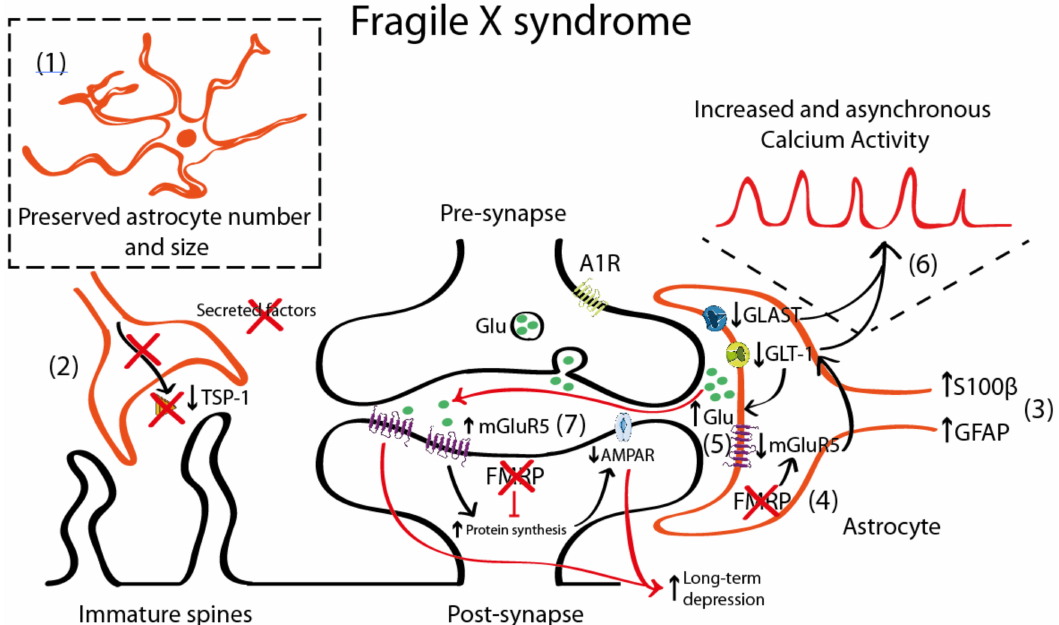
Figure 1. Schematic representation illustrating the astrocyte-synapse alterations in Fragile X syndrome (FXS). ( 1 ) Astrocyte number is preserved. ( 2 ) Reduced astrocyte secreted thrombospondin (TSP-1) prevents spine maturation resulting in more abundant filopodia (immature) spines. ( 3 ) Increased S100 calcium-binding protein β (S100 β ) and GFAP expression has been described in astrocytes. However, this altered expression has not been directly linked with their activity or function. ( 4 ) Fragile X Mental Retardation Protein (FMRP) absence in FXS astrocytes leads to metabotropic glutamate receptor 5 (mGluR5) downregulation in astrocytes (yet not in neurons) that negatively regulates glutamate transporter 1 (GLT-1) expression. Impaired glutamate transport due to decreased astrocyte glutamate-aspartate transporter 1 (GLAST-1) and GLT-1 expression increases extracellular glutamate levels ( 5 ) and astroglial calcium oscillations ( 6 ). This excess of glutamate might activate the postsynaptic mGluR5, which is overexpressed in neurons. ( 7 ) mGluR5 and FMRP oppositely regulate mRNA translation at the synapse: mGluR5 promotes it and FMRP prevents it. Therefore, increased mGluR5 expression and lack of FMRP in FXS leads to a disbalance in protein expression levels that account for many of the syndromic features of FXS including an α -amino-3-hydroxy-5-methyl-4-isoxazolepropionic acid receptor (AMPAR) internalization that leads to an exaggerated mGluR5-mediated long-term depression (LTD) that is reported in Fmr1 knock-out (KO)